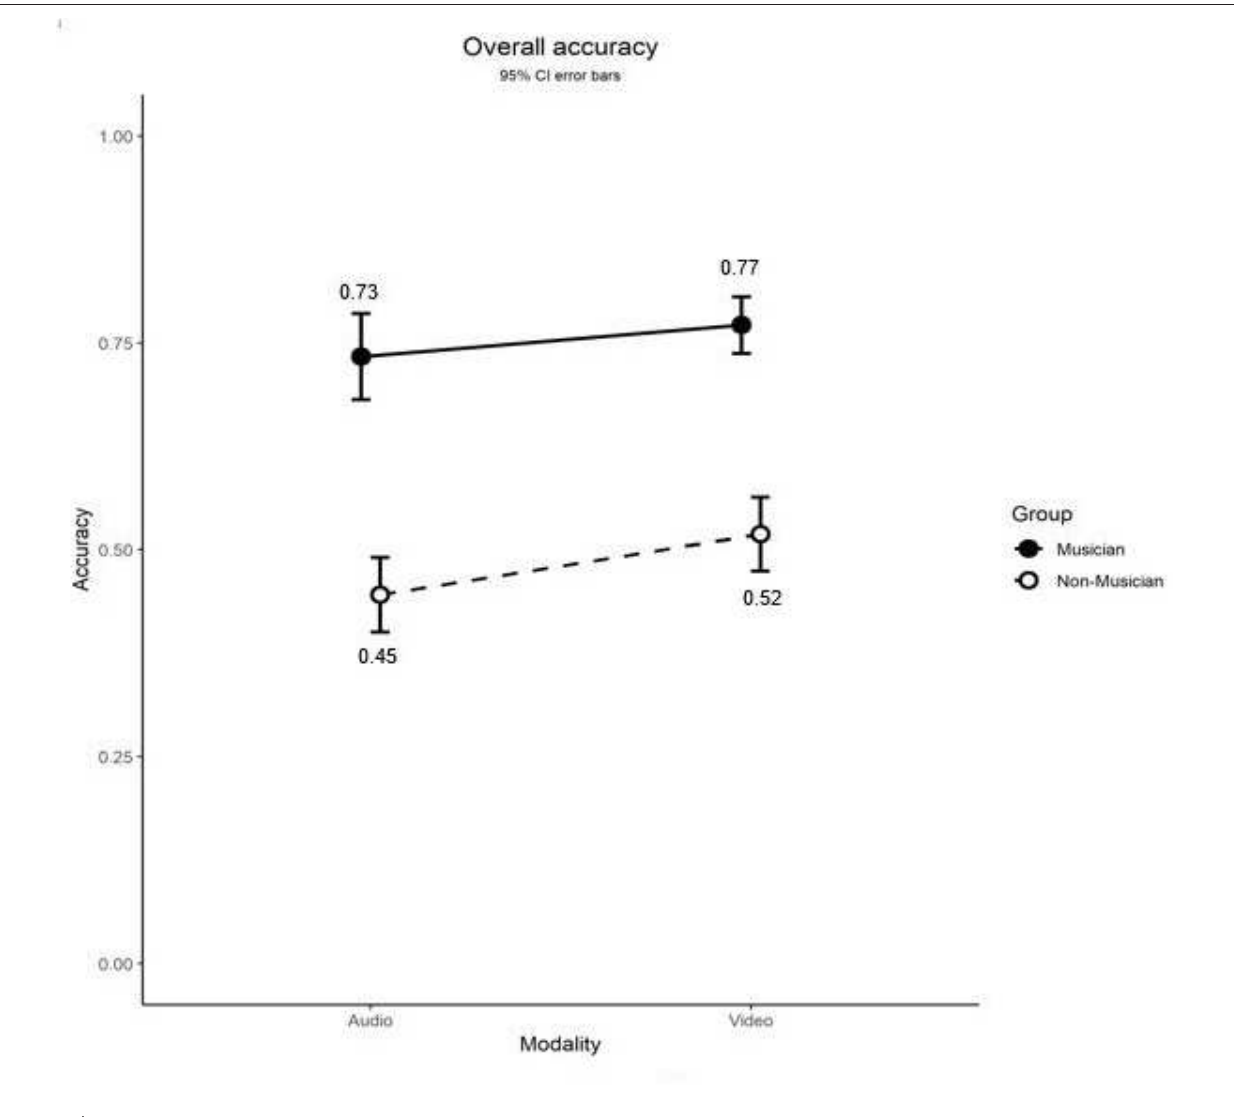
FIGURE 3 | Average accuracy in percentage correct of Mandarin tone identification as a function of musical background and modality. Video represents auditory-visual and Audio represents auditory-only. Error bars represent standard